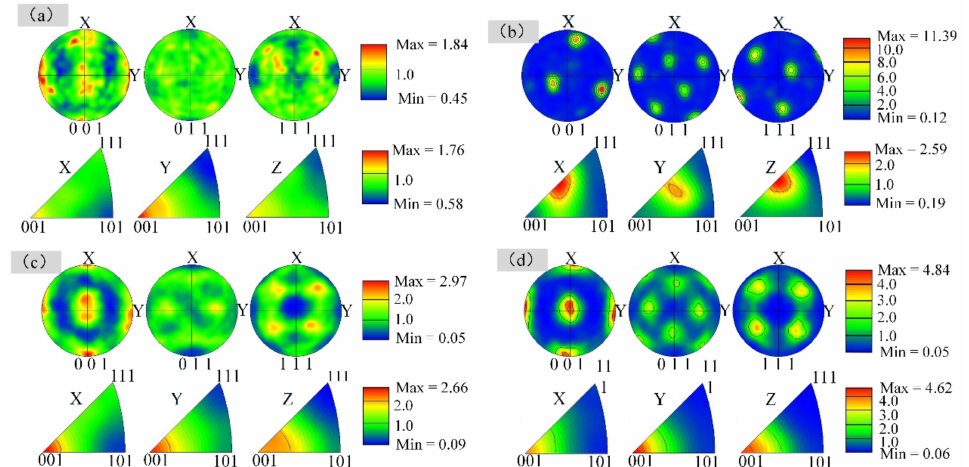
Figure 7. Crystal preferred orientations obtained through EBSD at various energy densities VED: